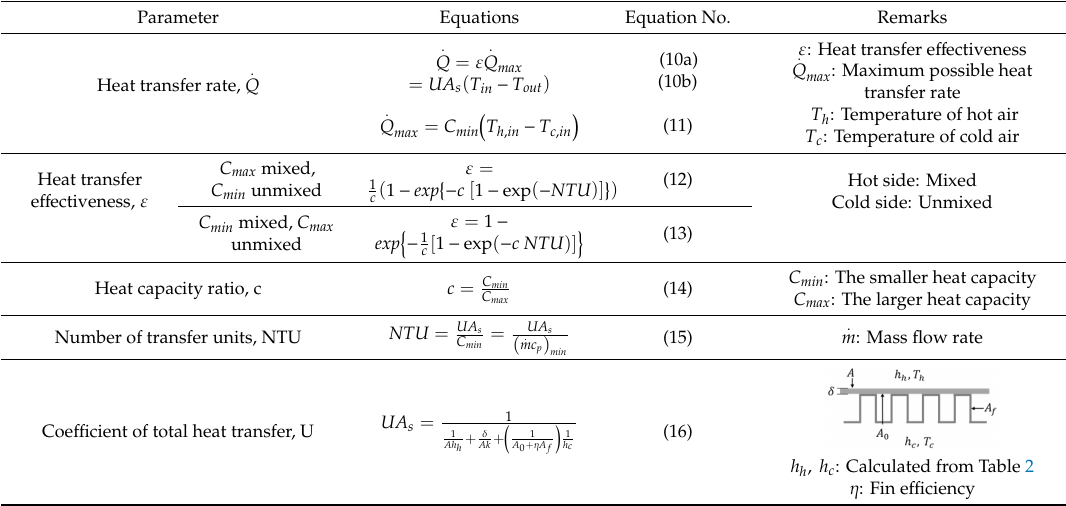
Table 3. Equations for calculating the heat transfer rate of the PFHE using the e ff ectiveness-NTU method [14].